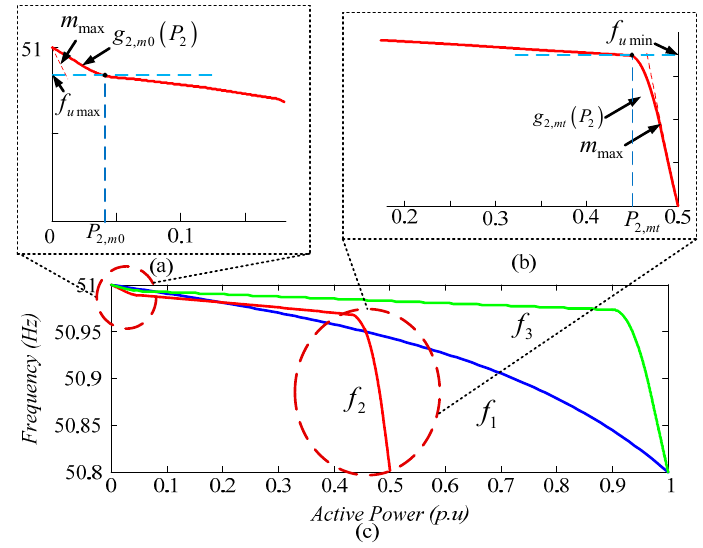
Figure 4. P-f characteristic curves of the distributed generations (DGs): ( a ) a zoomed-in portion of P-f characteristic curves of DG2 when P 2 locates in the range of [ P 2,min , P 2, m 0 ]; ( b ) a zoomed-in portion of P-f characteristic curves of DG2 when P 2 locates in the range of [ P 2, mt , P 2,max ]; and ( c ) P-f characteristic curves of the DGs under the proposed scheme.